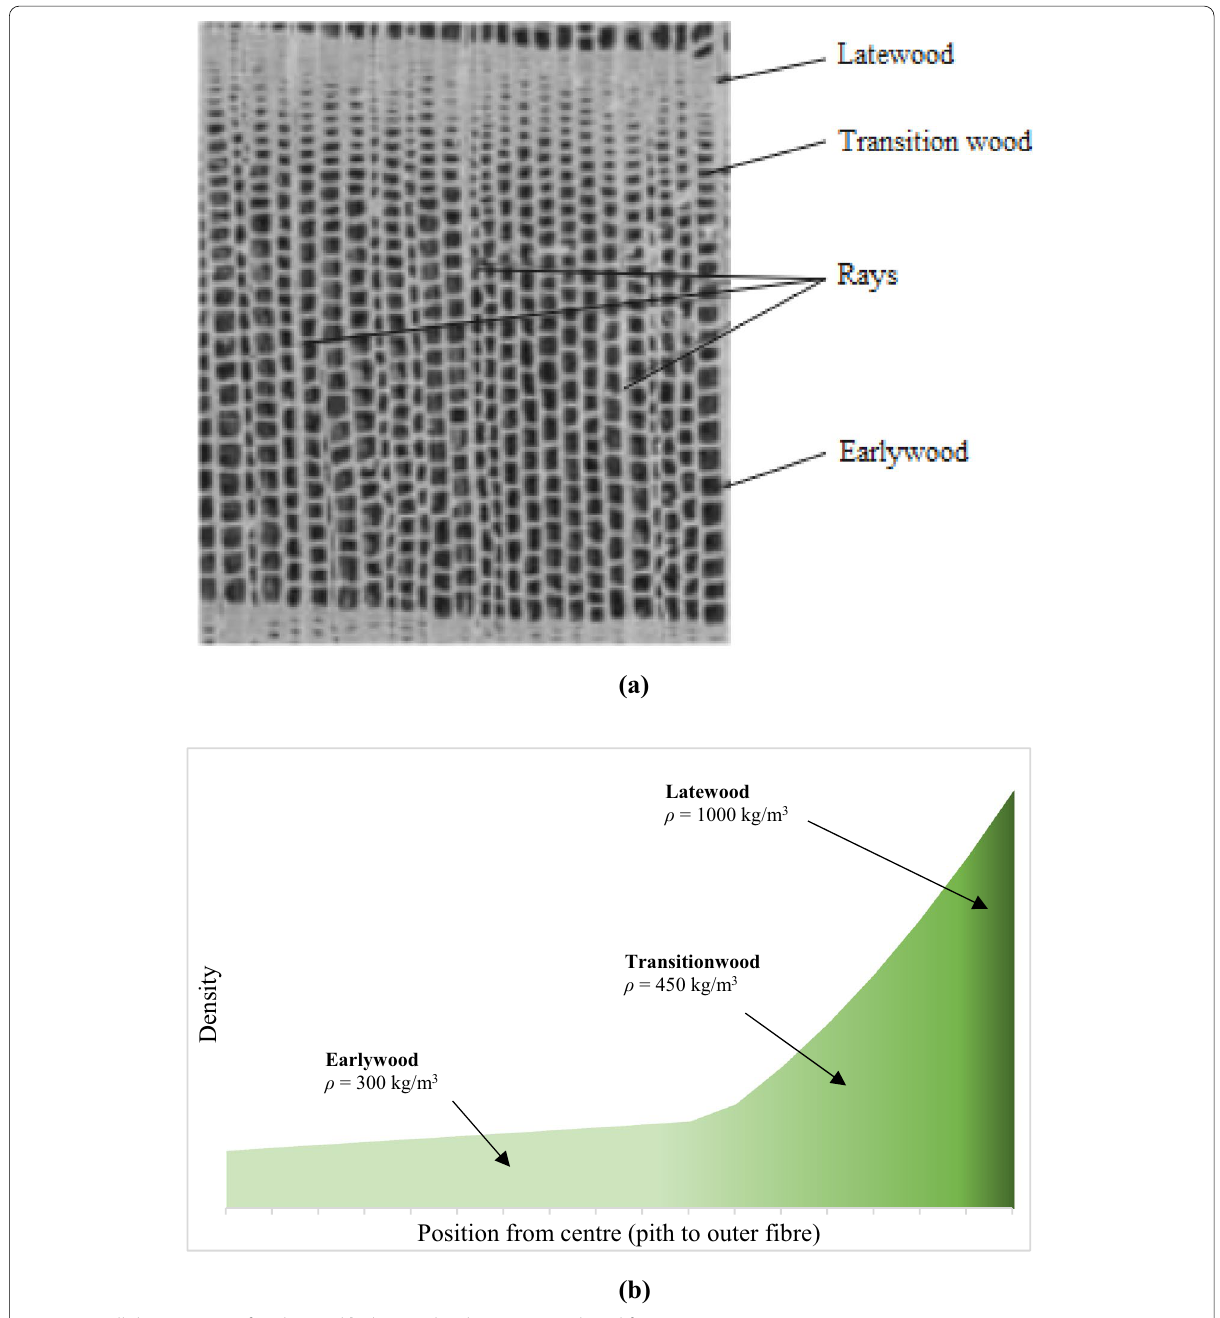
Fig. 1 a Cellular structure of timber and b density distribution (reproduced from